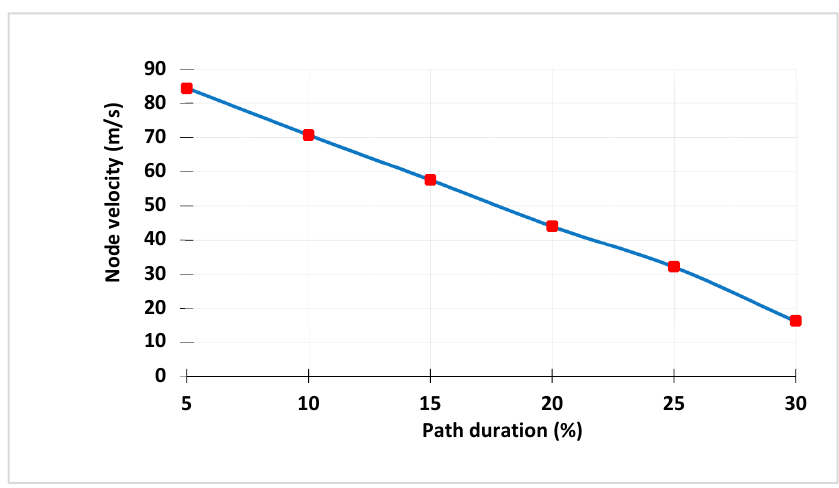
Figure 10. Utilization ratio of the path duration vs. the velocity of the node.